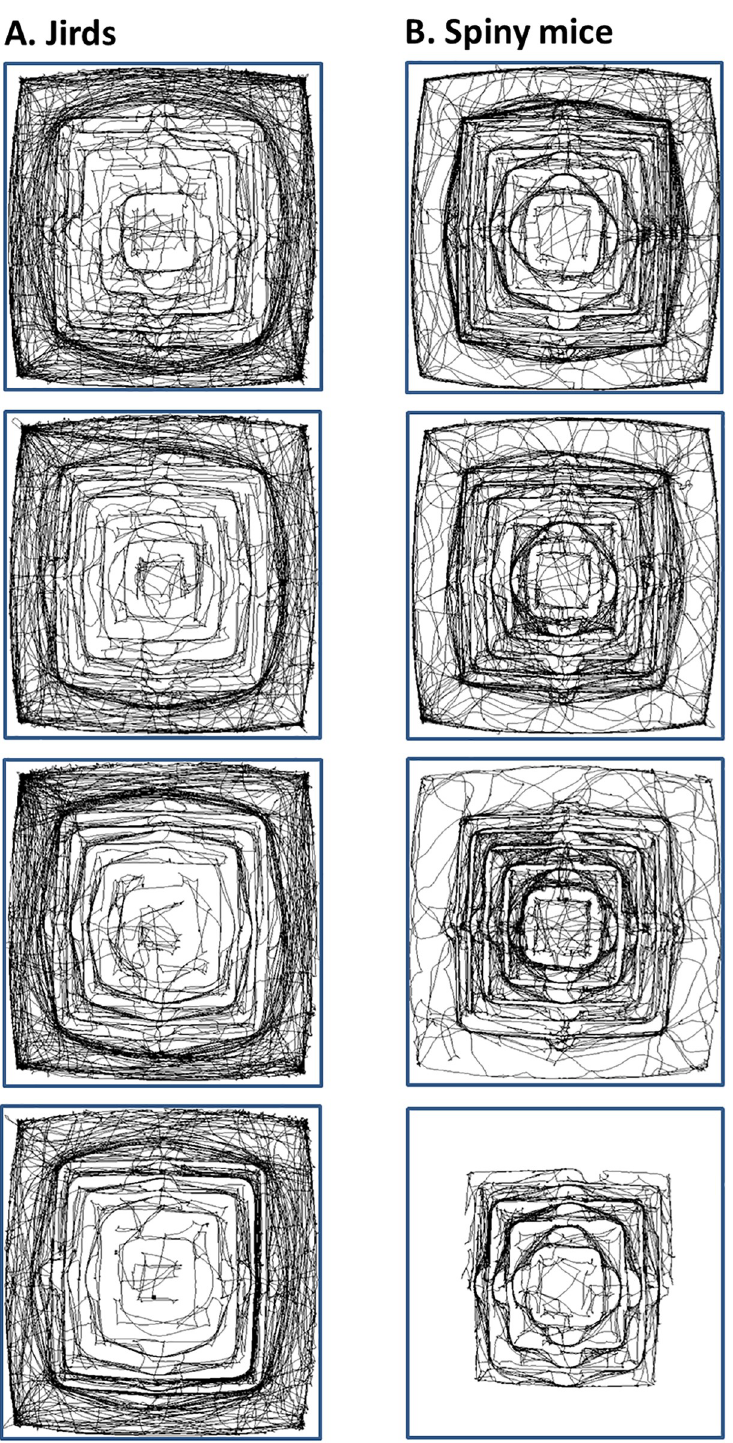
Fig 7. Representative trajectories of locomotion of jirds (A) and spiny mice (B). As shown, jirds travelled mostly on the floor or near it, whereas spiny mice travelled mostly on the pyramid and next to its base (note that in the figure there is one spiny mouse that never descended to the floor; another three spiny mice also did not get to the floor). Note that the structure of the apparatus is apparent solely from the trajectories.